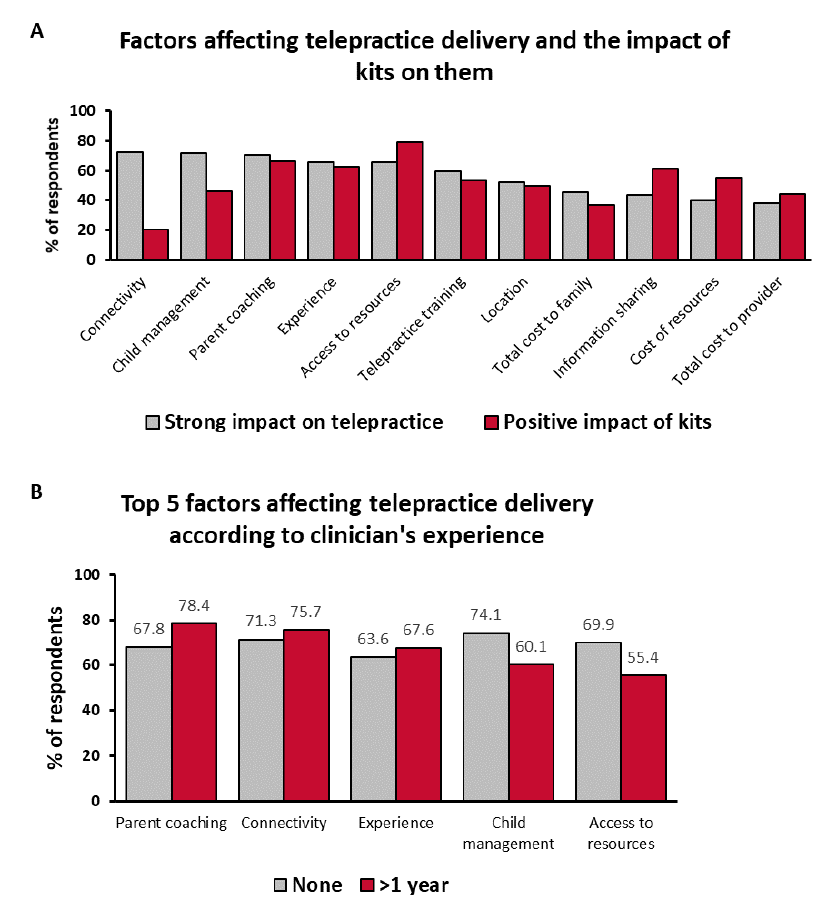
Note. Figure 6.A: Proportion of respondents believing that these factors have a strong impact on telepractice delivery (gray, n = 273) and that they were positively affected by the MED-EL Remote Lesson Kits (red, n = 109); Figure 6.B: Top 5 factors having a strong impact on telepractice delivery according to clinician’s experience with telepractice (gray: no experience, n = 143; red: more than 1 year of experience, n =